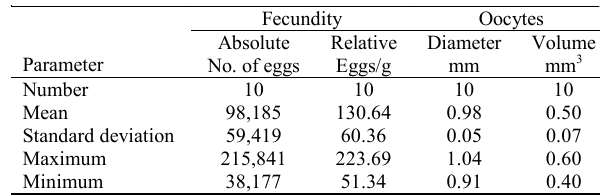
Table 2 . Values of fecundity and oocyte size of Rhaphiodon vulpinus in the Tocantins river.